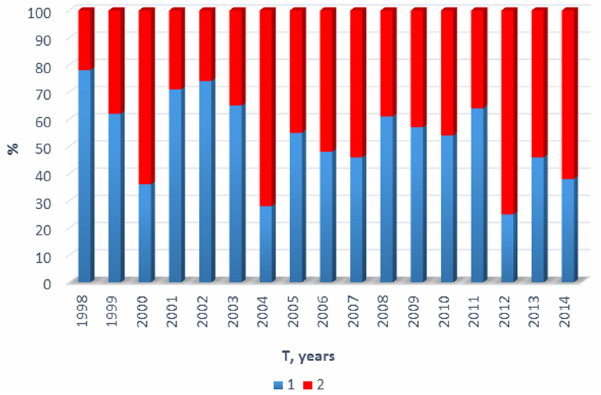
Figure 5. Annual contribution (in %) of snow-melting and rain- storms in annual gully head retreat rates for the period 1998–2014 (Legend: 1 – period of snow-melting; 2 – rain-storms period).